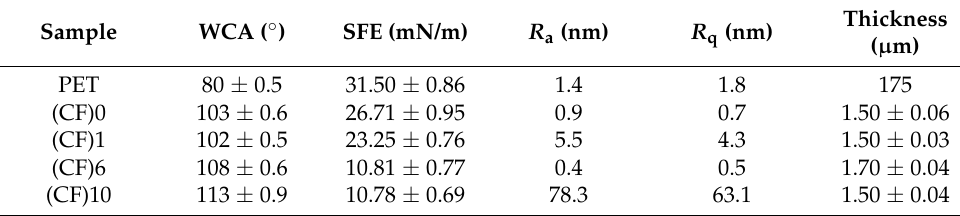
Table 2. Values of roughness ( R a and R q ) and wettability (water contact angle, WCA) parameters, surface free energy (SFE), and thickness of obtained layers and PET substrate for